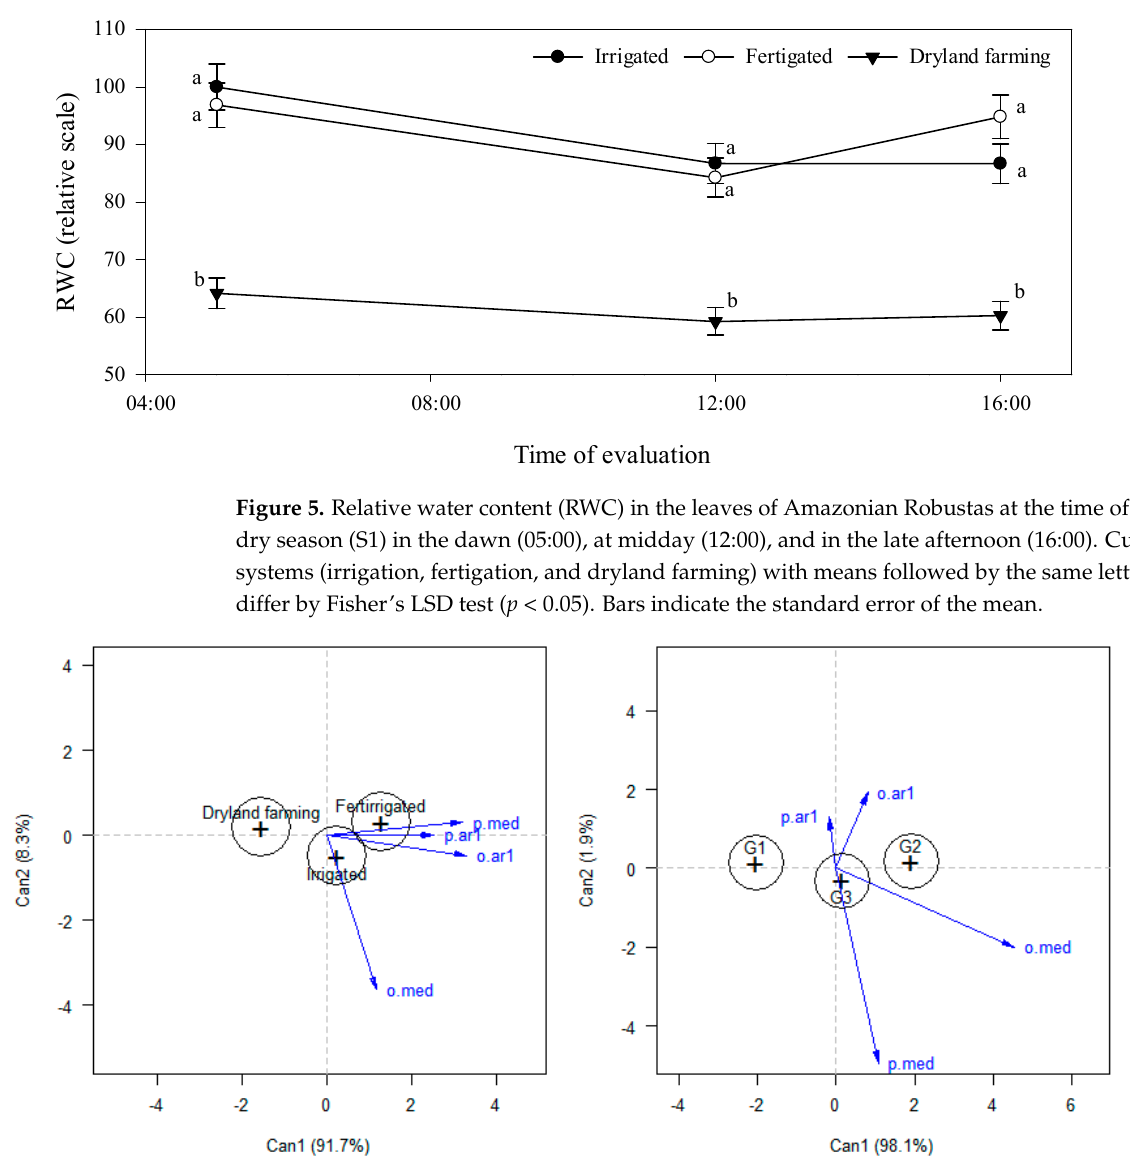
Figure 6. Biplot containing mean scores and 95% confidence ellipses for the first two canonical discriminating variables of systems ( left ) and clones ( right ), built from growth variables of plagiotropic and orthotropic branches (p.med and o.med– estimates of the average growth of the plagiotropic and orthotropic groups, respectively; p.ar1 and o.ar1—parameters of temporal